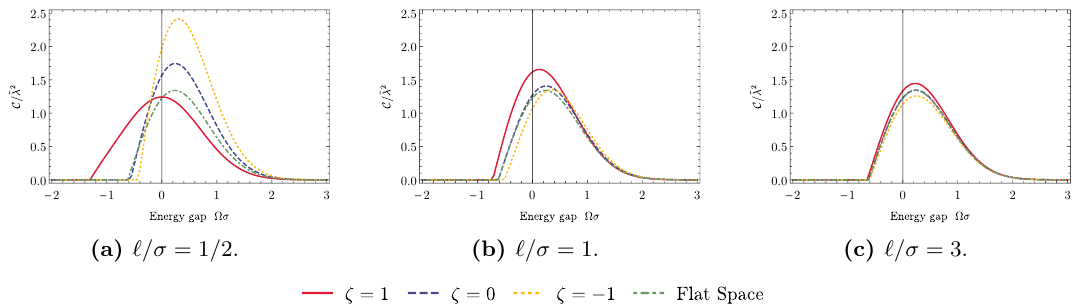
Figure 14 . The concurrence C = ~ (cid:21) 2 associated with the state (cid:26) AB describing detector A located at the origin and detector B on a circular geodesic orbit around the origin is plotted as a function of their energy gap (cid:10) (cid:27) for di(cid:11)erent values of the AdS length ‘=(cid:27) . The proper separation of the detectors is d ( R A ; R B ) =(cid:27) = 1 =